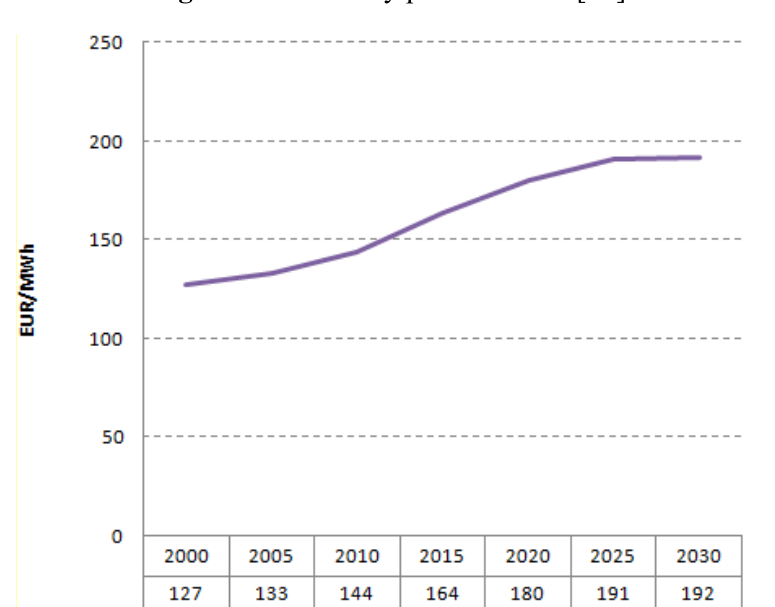
Figure 8. Electricity price forecast